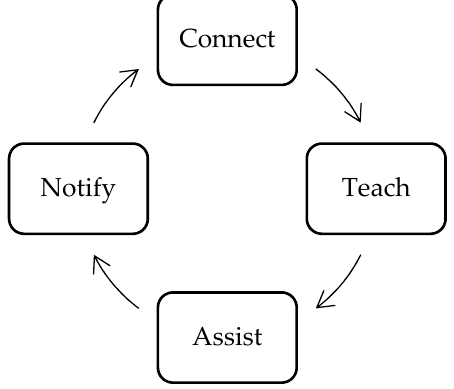
Figure 8. Social media process flow.